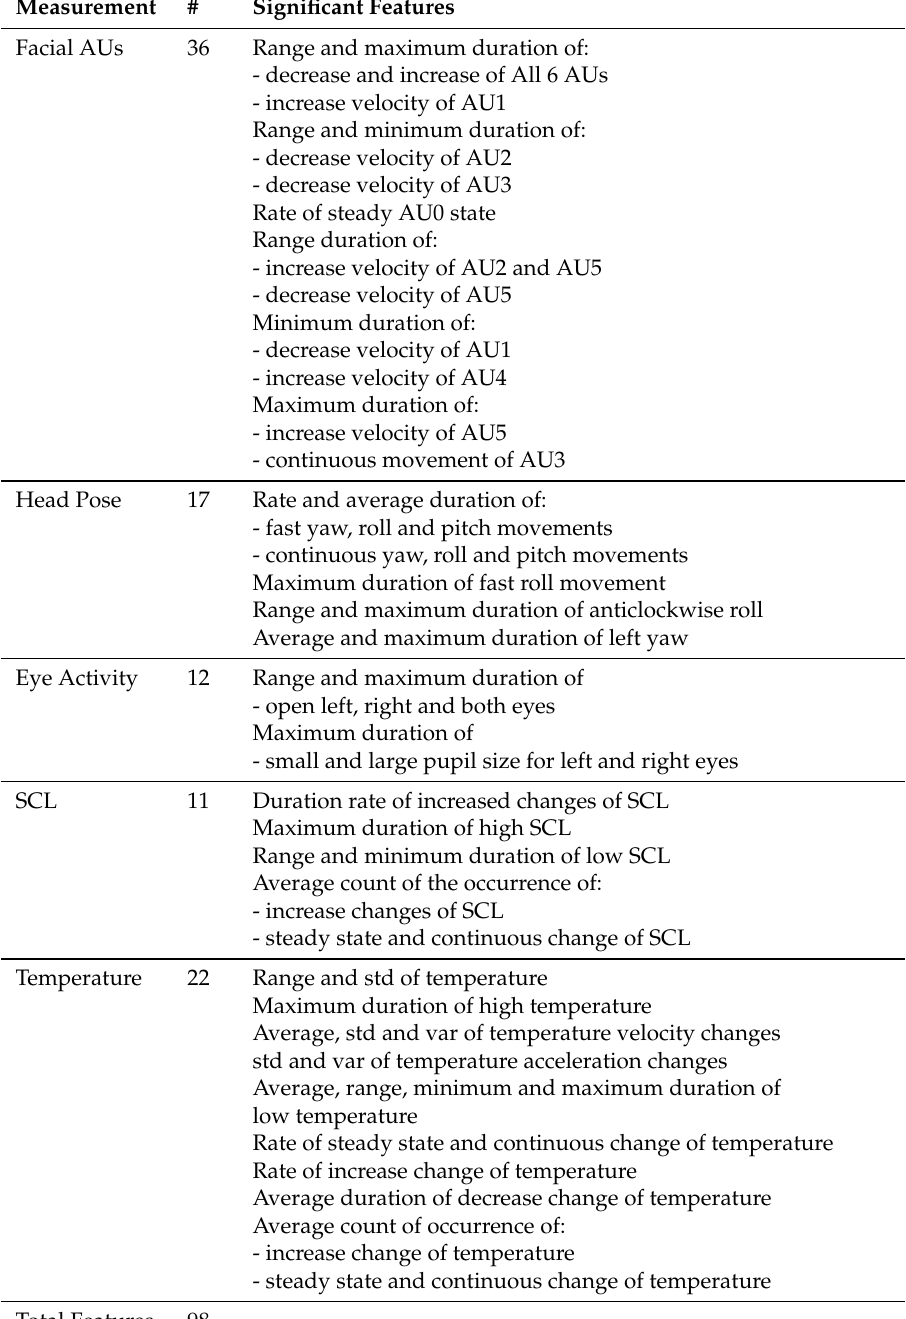
Table 7. Summery of selected measurements with significant differences between the 6 elicited emotions from both English and Arabic clips based on the ANOVA group test. SCL, Skin Conductivity Level. Measurement # Significant